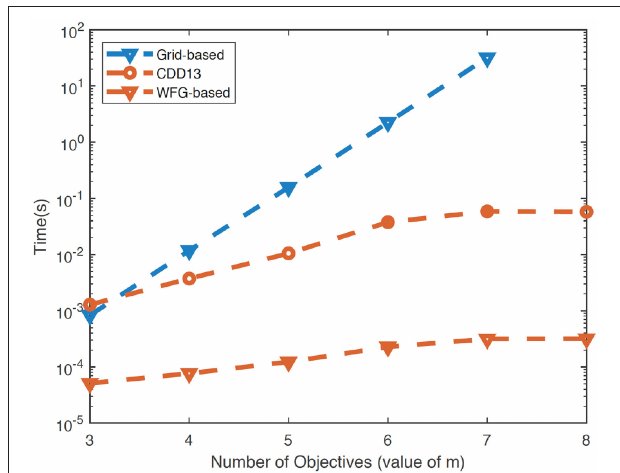
FIGURE 6 | Comparison between traditional (grid-based) and fast approaches (CCD13, WGF) for computing the EHVI with arbitrary number of objectives. WFG corresponds to the updated framework developed in (Zhao et al.,